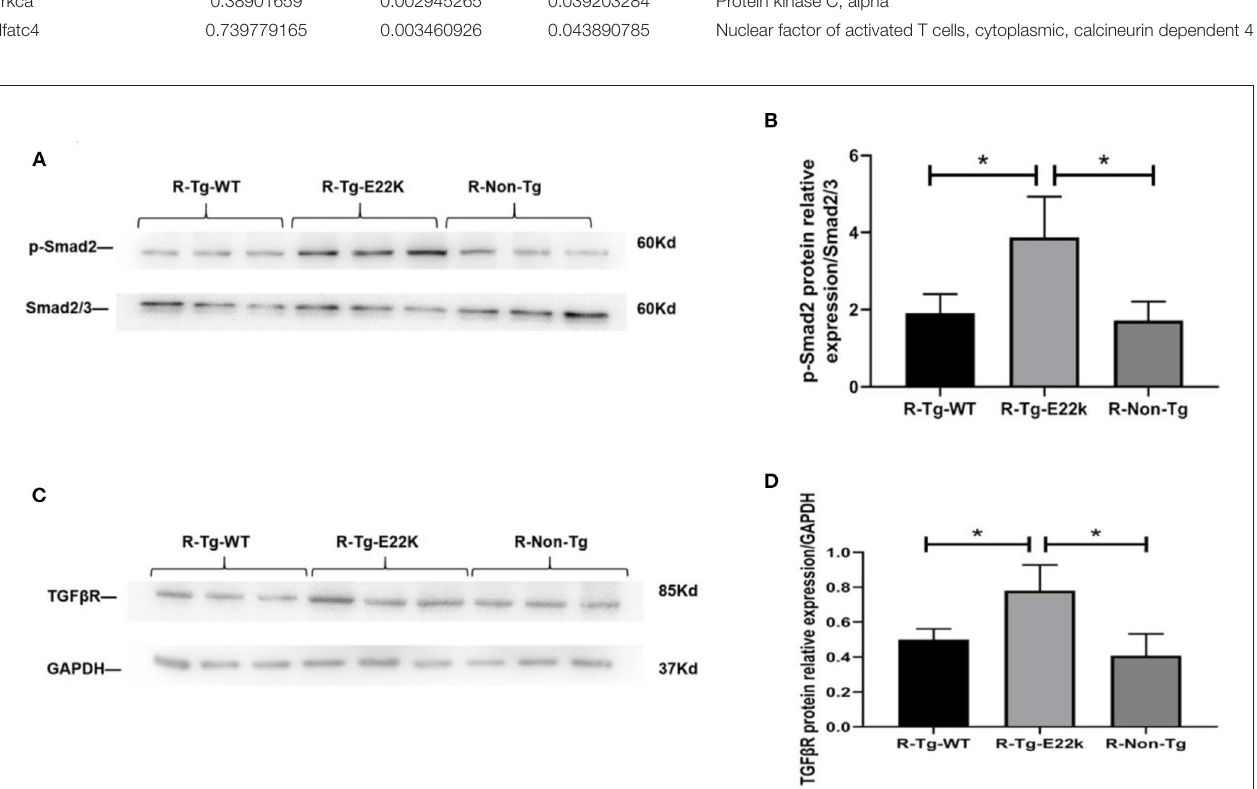
FIGURE 2 | E22K mutation elevates the protein expression of p-Smad2 and TGF β R. Representative Western blot results demonstrated the upregulated expression of TGF β R and increased phosphorylation of Smad2 in R-Tg-E22K mouse hearts compared to those in R-Tg-WT and Non-Tg mouse hearts (A,C) . Densitometric analysis of the protein levels of p-Smad2 and TGF β R in each group (B,D) . N = 3, * p < 0.05. R-Tg-WT, wild-type transgenic mice in the rest group; R-Tg-E22K, transgenic E22K mice in the rest group; R-Non-Tg, non-transgenic wild-type mice in the rest